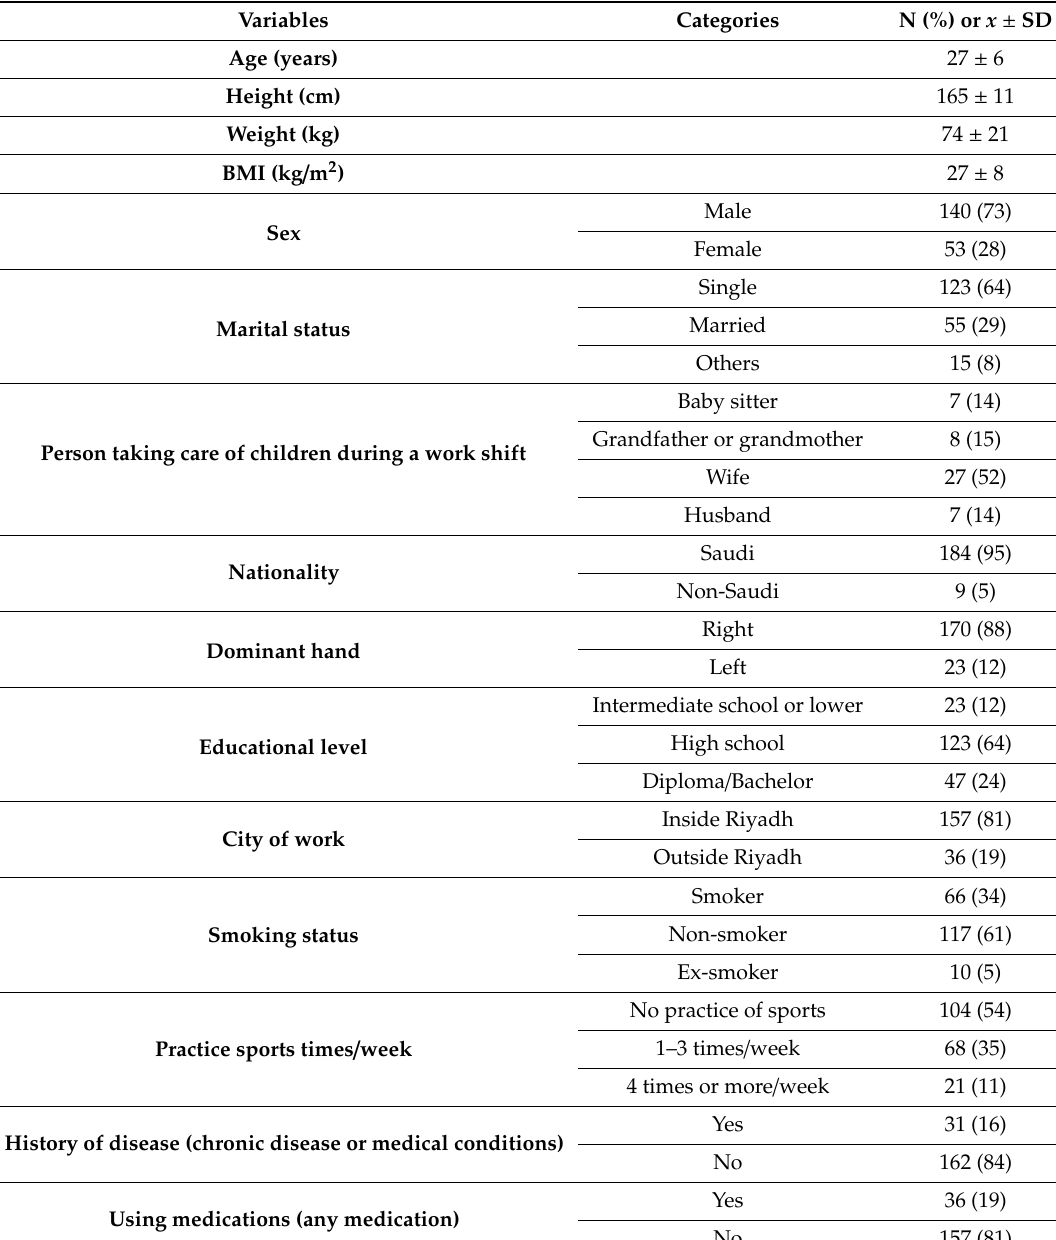
Table 1. Summary statistics of demographic and health-related